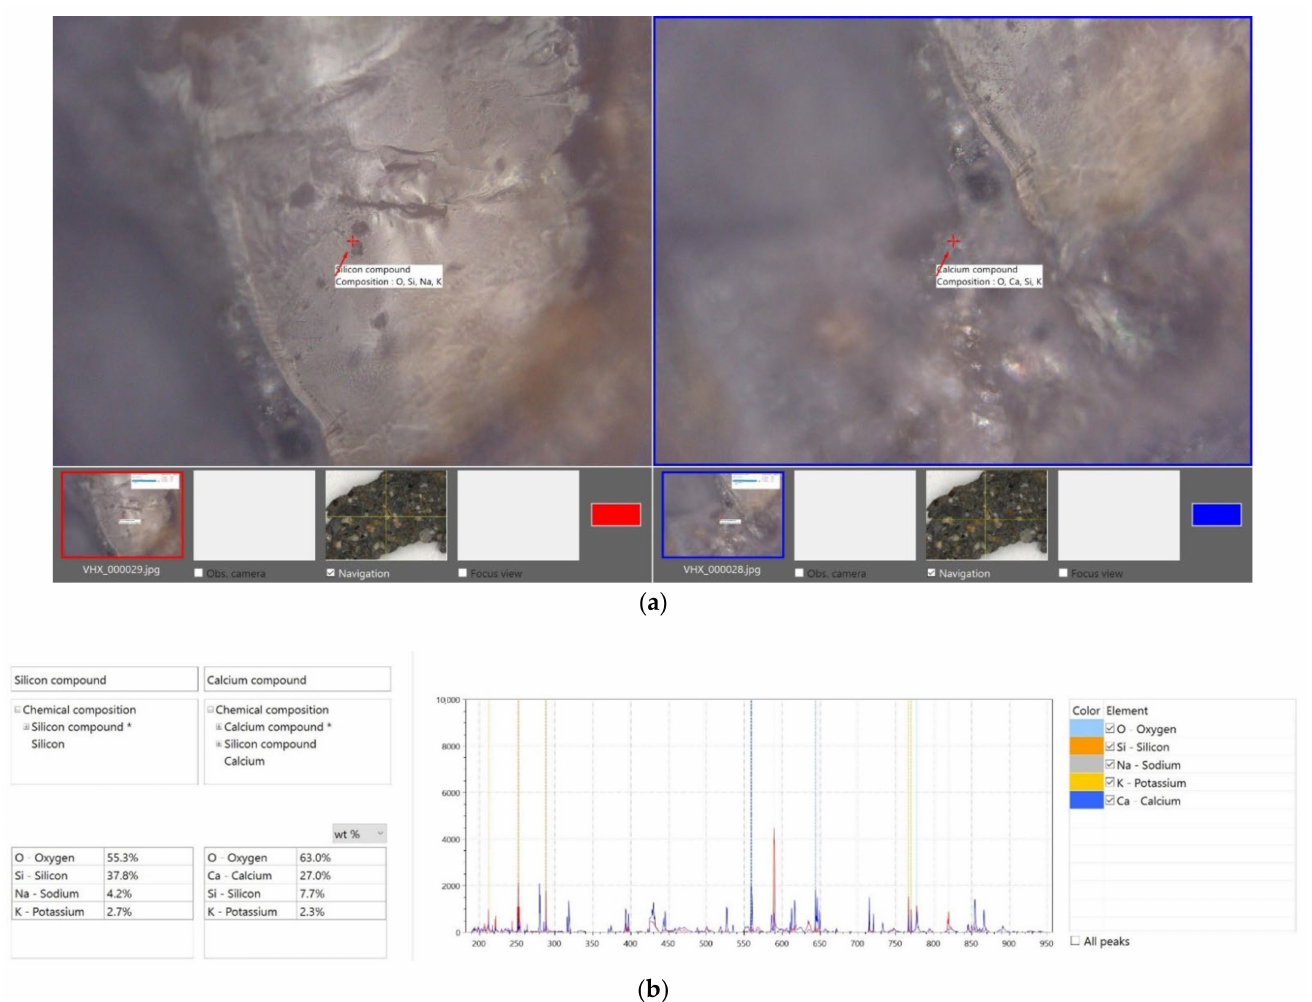
Figure 11. Material analysis using high-speed analysis (LIBS). ( a ) Microstructure photograph, ( b ) elemental composition for the selected location of the microstructure.